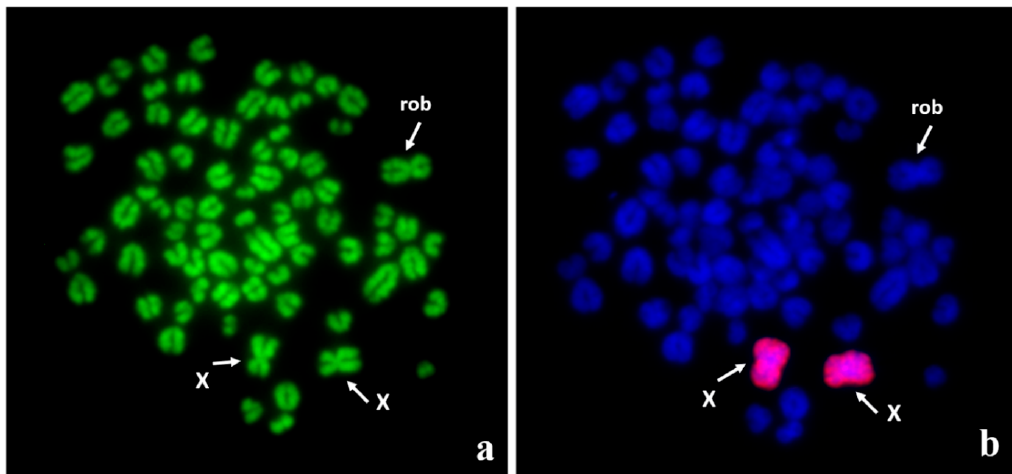
Figure 2. Robertsonian translocation, 77,XX, rob(5;23) in an infertile DSD female dog: ( a ) Q-banded metaphase spread with three biarmed chromosomes; ( b ) the same metaphase spread after fluorescence in situ hybridization (FISH) using whole X chromosome painting probe to facilitate recognition of X chromosomes from the fused chromosome (rob). The autosomes involved in the translocation were identified by FISH with locus-specific probes (for details, see